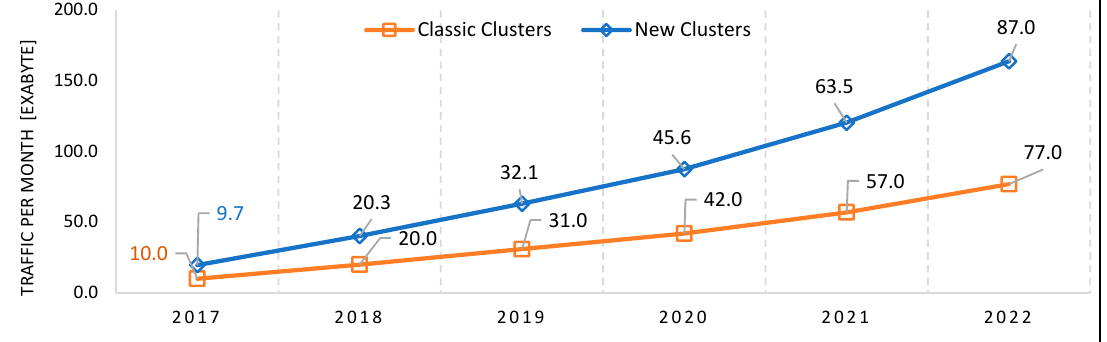
Figure 17. Traffic per month considering four (classic) and two (new) clusters. Figure 17. Tra ffi c per month considering four (classic) and two (new)